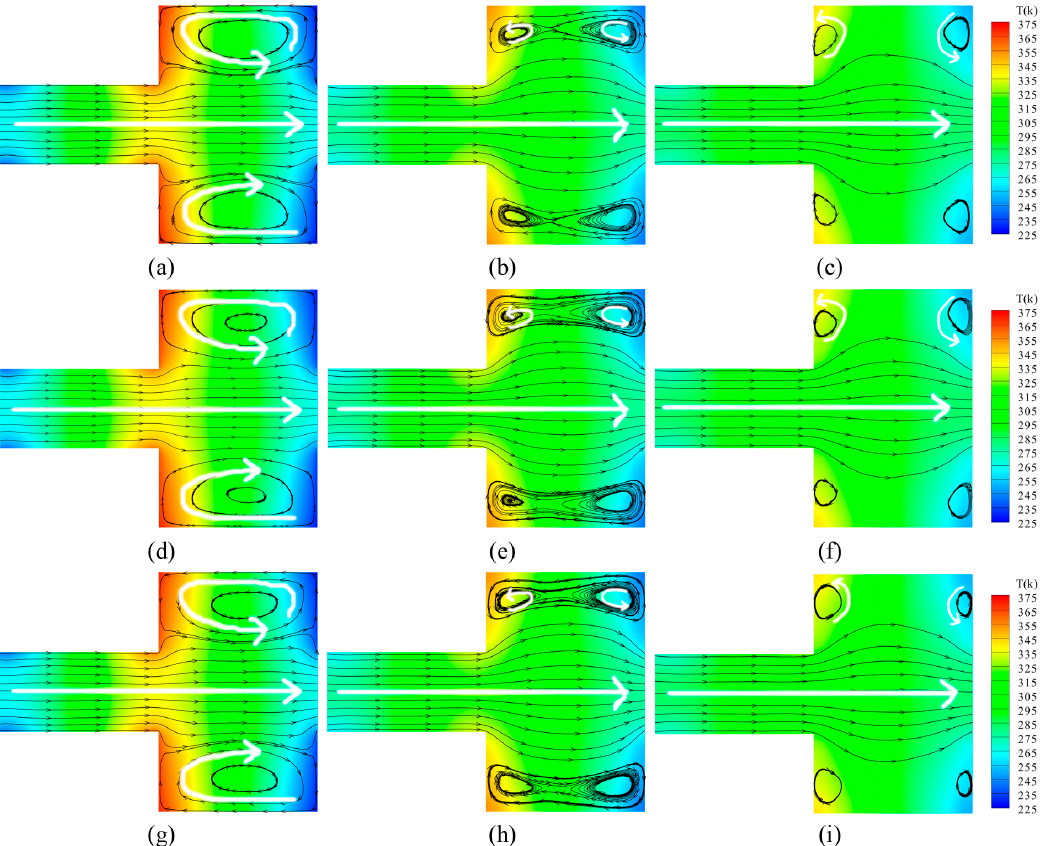
Figure 5. Velocity streamlines and temperature contours for different ratios of N 2 and O 2 and different Knudsen numbers. ( a ) N 2 and O 2 = 4:1, Kn = 0.055; ( b ) N 2 and O 2 = 4:1, Kn = 0.387; ( c ) N 2 and O 2 = 4:1, Kn = 3.87; ( d ) N 2 and O 2 = 1:1, Kn = 0.055; ( e ) N 2 and O 2 = 1:1, Kn = 0.387; ( f ) N 2 and O 2 = 1:1, Kn = 3.87; ( g ) N 2 and O 2 = 1:4, Kn = 0.055; ( h ) N 2 and O 2 = 1:4, Kn = 0.387; ( i ) N 2 and O 2 = 1:4, Kn = 3.87.